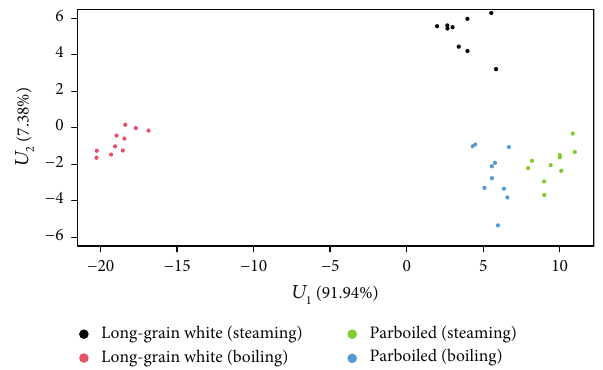
Figure 5: Plotted values of the fi rst two functional discriminant coordinates. Table 2: Mean values of the four